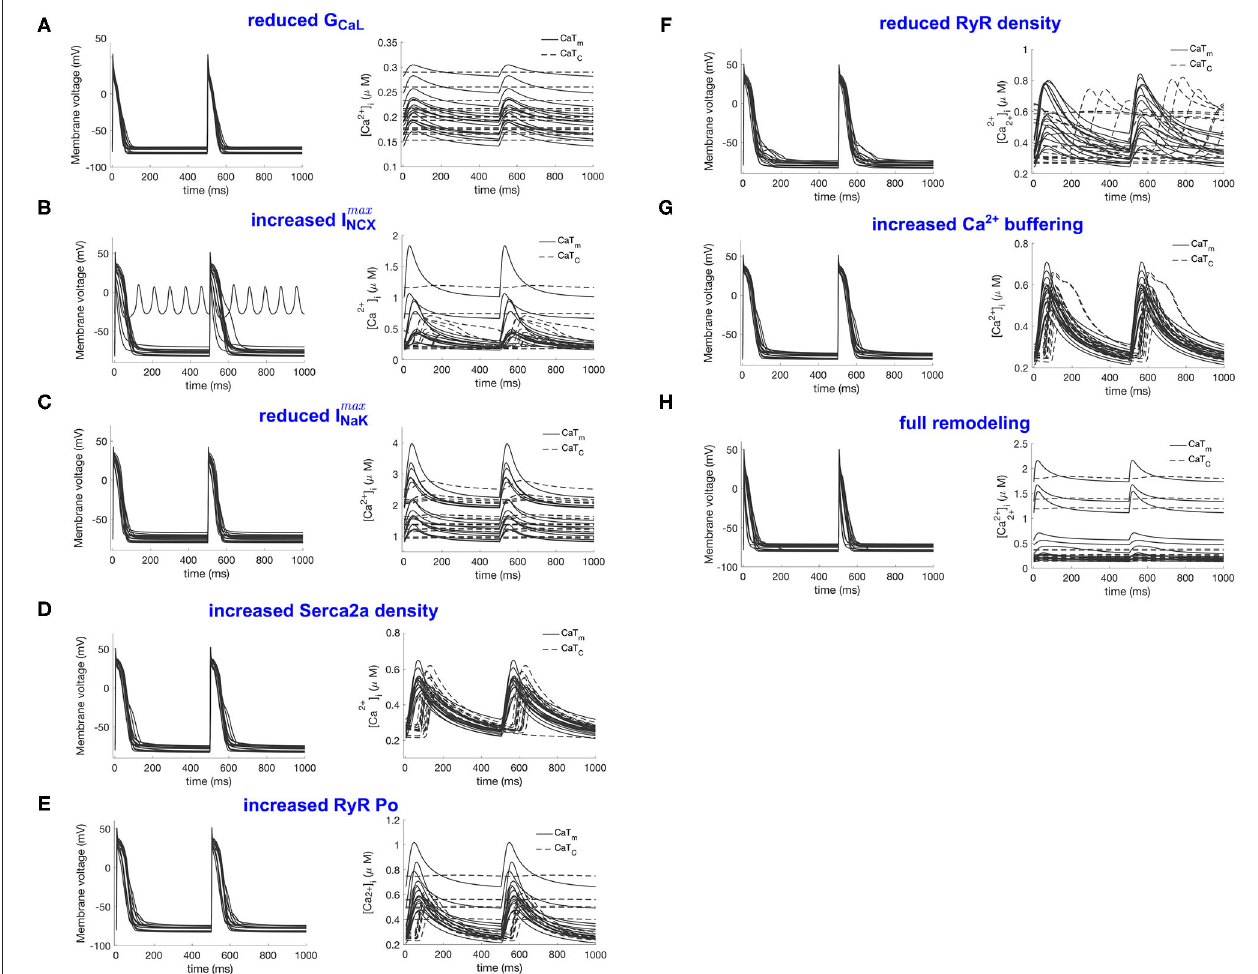
FIGURE 3 | Illustration of the RAP remodeled populations. (A–H) Refer to the remodeled populations described in section 2.2, as indicated by the panel titles. For each population the action potentials are shown in the left panel and the CaT m and CaT c traces in the right